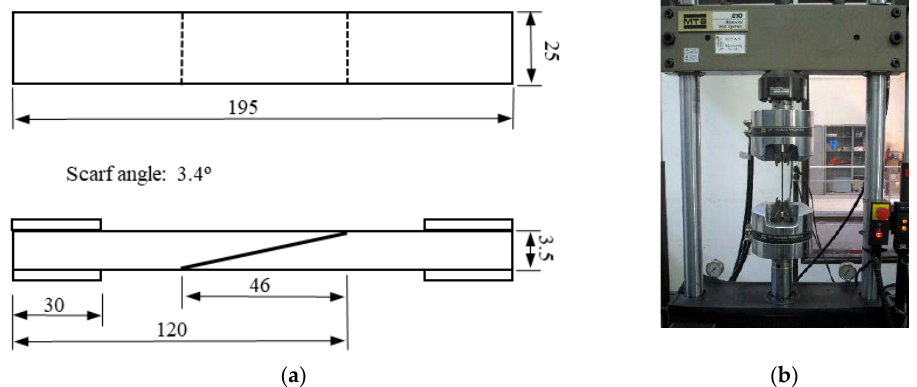
Figure 4. ( a ) Geometry and dimensions of the scarfed sample; ( b ) photograph showing a scarfed specimen under tensile loading.